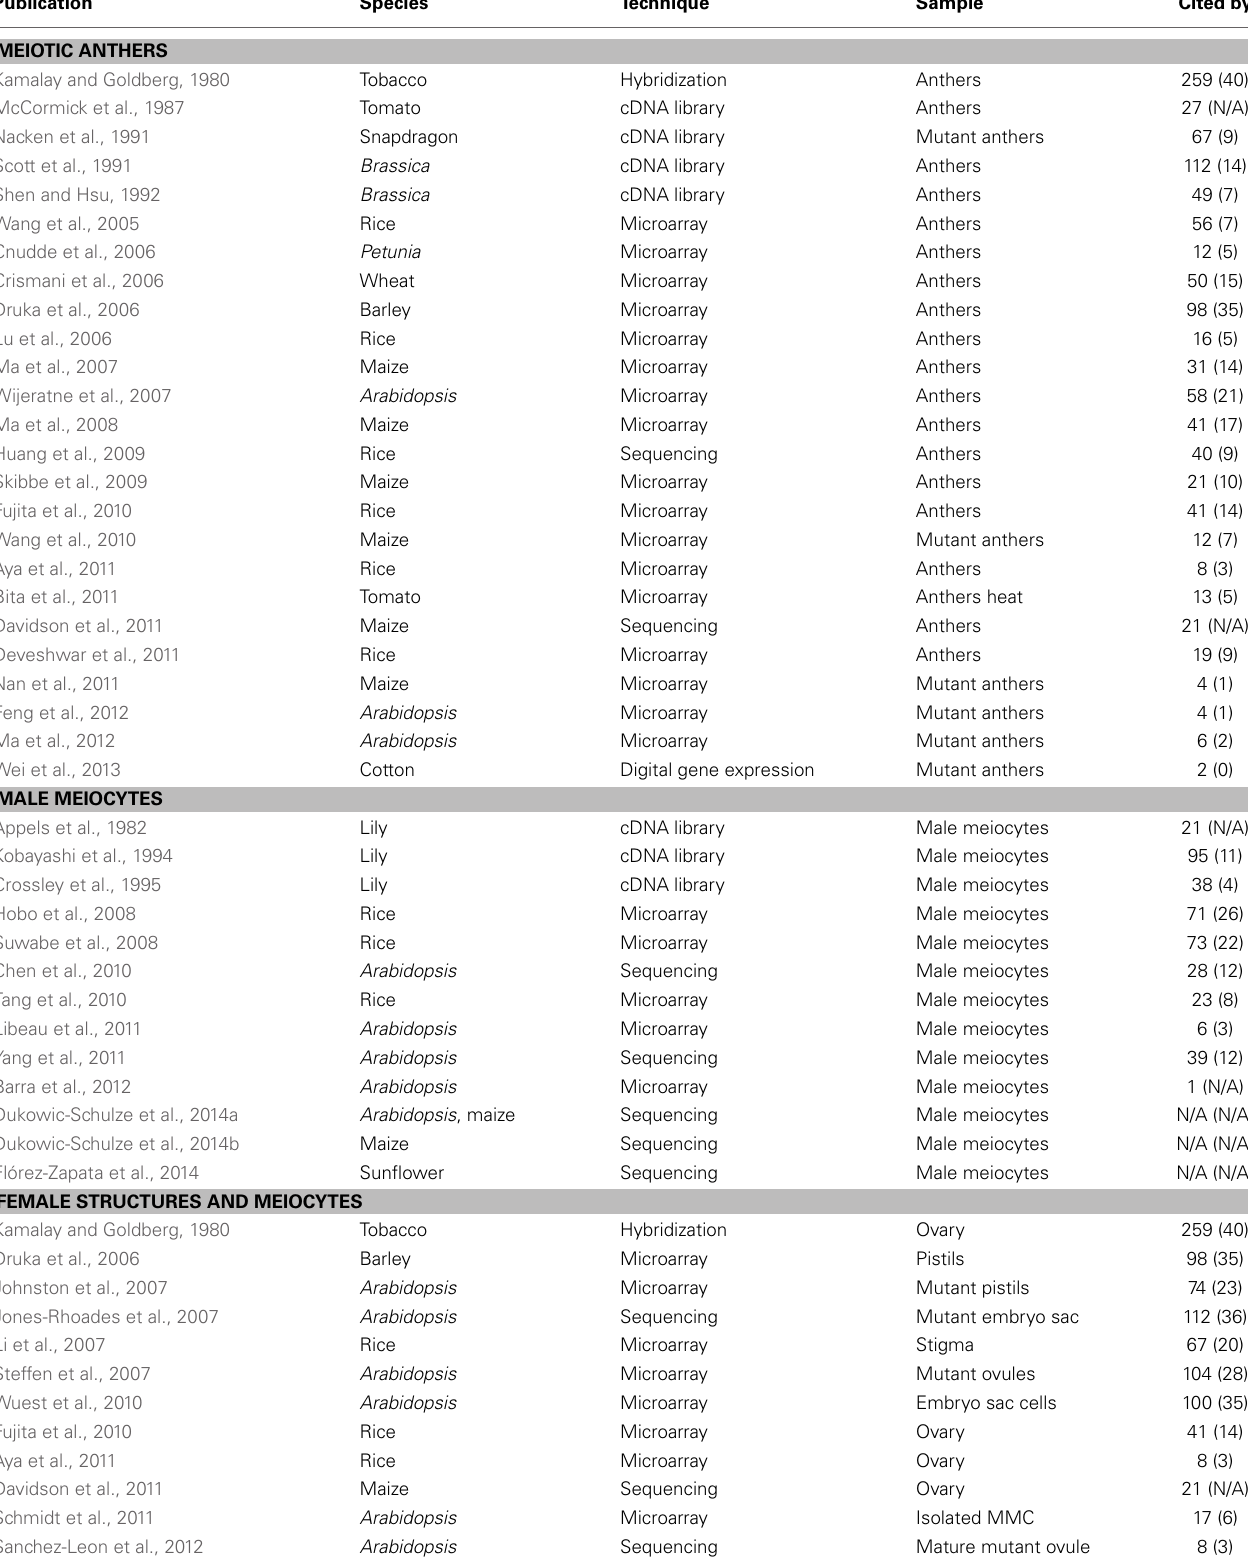
Table 1 | List of published literature regarding the transcriptome of reproductive